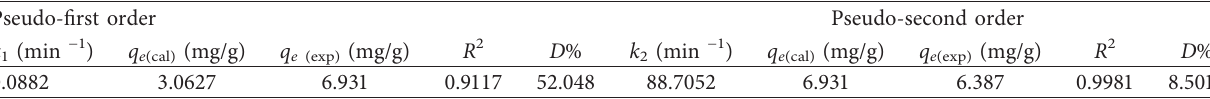
Figure 5: Conversion of GV in acidic and basic Table 2: Adsorption kinetics parameters for adsorption of GV onto HAB.